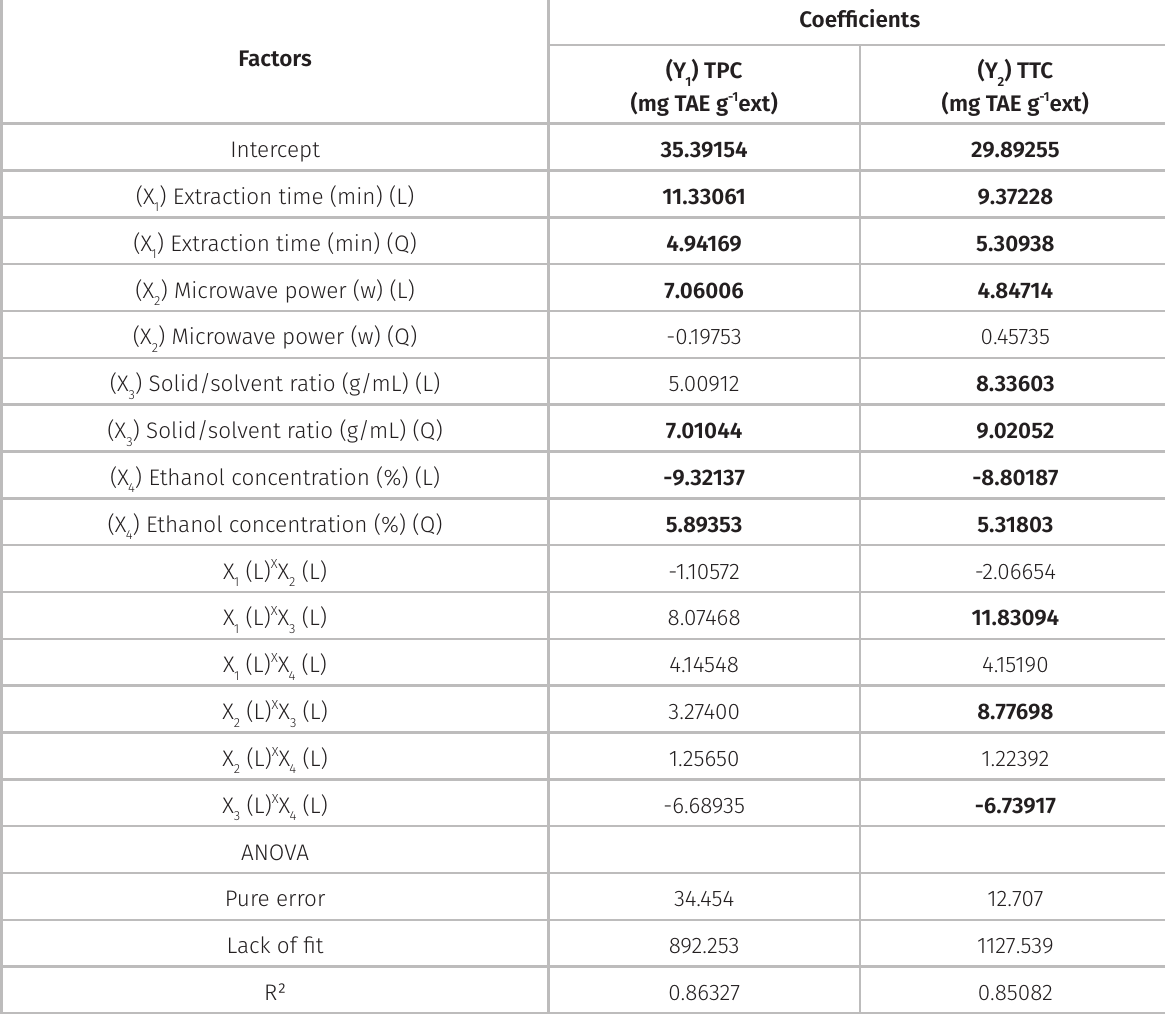
Table III. Estimated effects and analysis of variance (ANOVA) of the Box-Behnken design for optimizing TPC and TTC in the liquid extract from S. cumini leaves through microwave-assisted extraction. Significant values (p < 0,05) are in